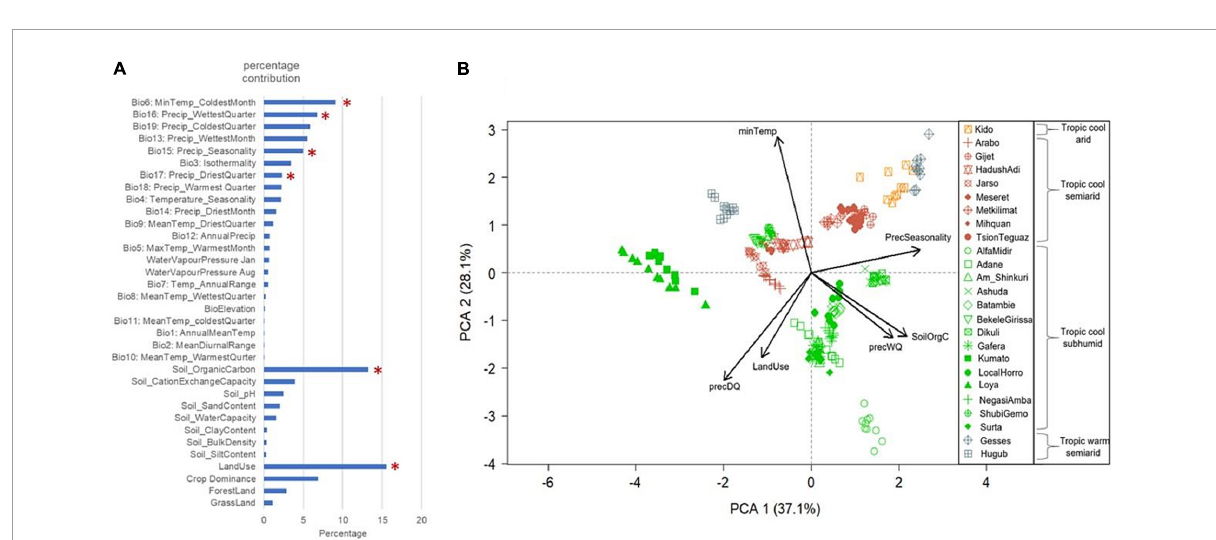
FIGURE3 Environmental variables used in ENM for characterising Ethiopian chicken agro-ecologies. (A) Relative contribution of the 34 agro-climatic variables examined in Ethiopian chicken agro-ecologies. Asterisks mark the variables that were shortlisted for final modelling. (B) PCA plot of populations based on six shortlisted variables. The colour coding shows the population classification based on Global AEZ-16. Arrow direction shows the contributing variables in spreading the samples and arrow length indicates relative contribution.